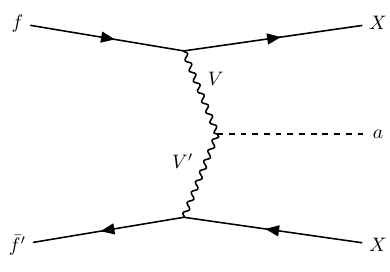
Figure 1 . Feynman diagram for the VBF production of ALP at a